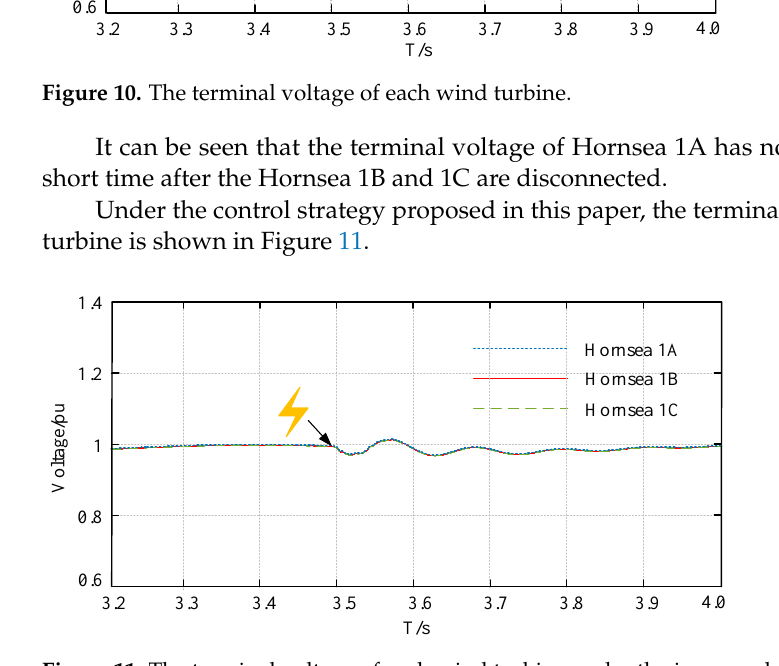
Figure 11. The terminal voltage of each wind turbine under the improved control.